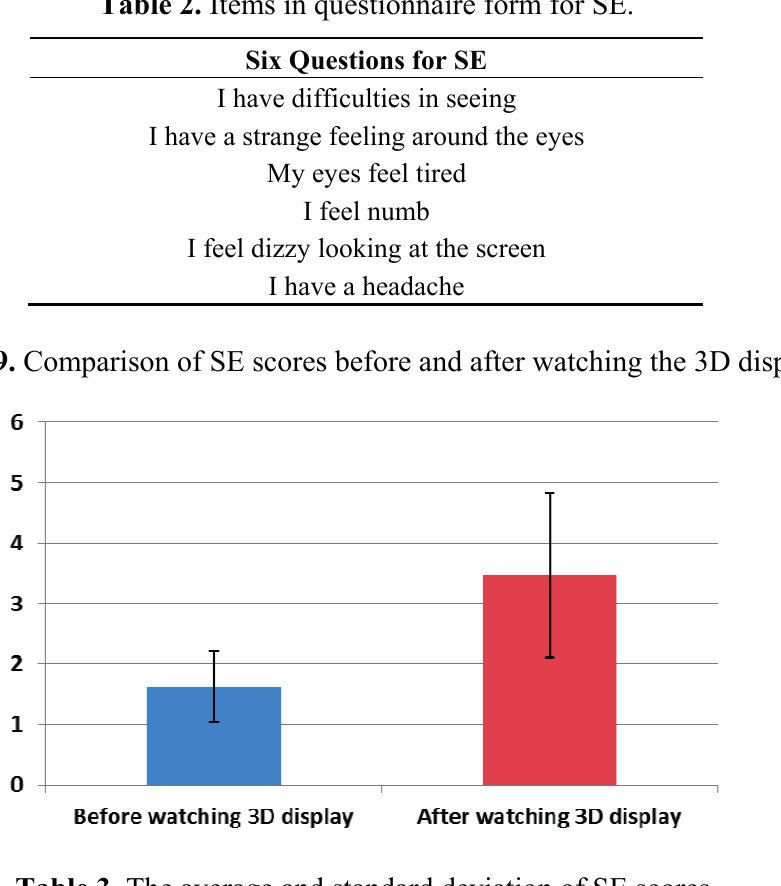
Table 3. The average and standard deviation of SE